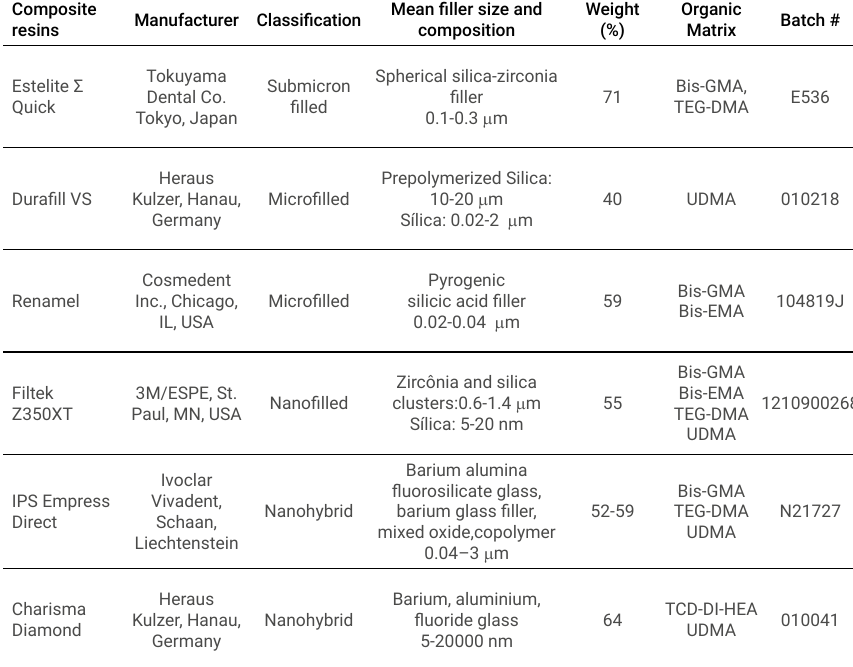
Table 1. Characteristics of composites materials analyzed in this